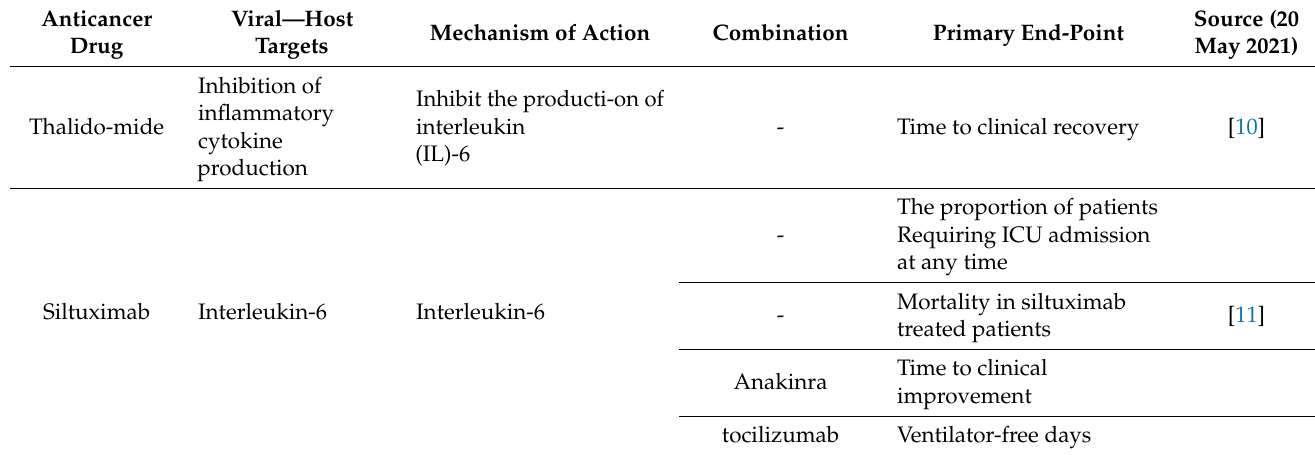
Table 2. Anticancer drugs in clinical trials for COVID-19: Anti-cytokine agents.